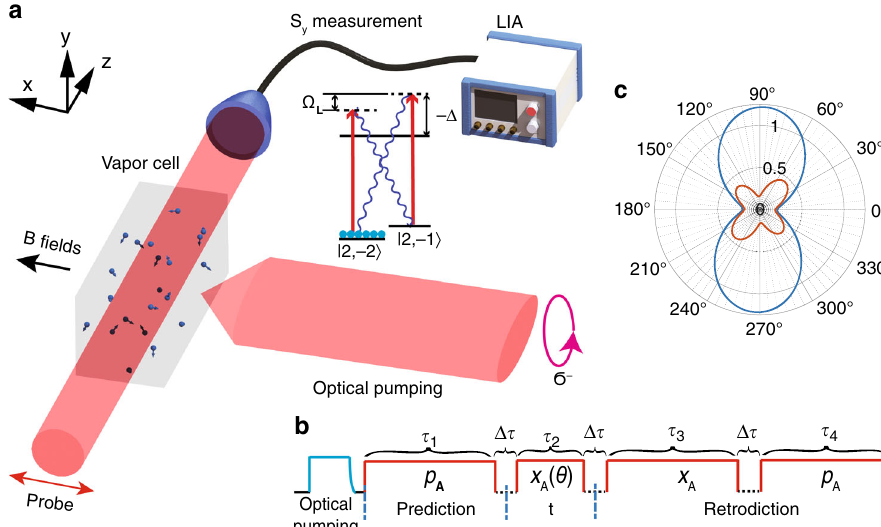
Fig. 1 Schematics for retrodiction beyond the Heisenberg uncertainty relation. a Experiment schematics. A paraf fi n coated 20mm × 7mm × 7mm rectangular vapor cell at 53 °C resides inside a 4-layer magnetic shielding. A coherent spin state (CSS) is created along the quantization axis x by optical pumping, with a pump laser tuned to the Rb D1 transition 5 S 1 = 2 ; F ¼ 2 ! 5 P 1 = 2 ; F 0 ¼ 2 and a repump laser beam stabilized to the Rb D2 transition 5 S 1 = 2 ; F ¼ 1 ! 5 P 3 = 2 ; F 0 ¼ 2, sharing the same circular polarization. A magnetic fi eld of 0.71G induces a ground-state Zeeman splitting of about Ω = 2 π × 500 kHz and stabilizes the collective spin component along the x direction. A linearly polarized off-resonance D2 laser beam, propagating in the L ∘ basis is measured z direction, probes the quantum fl uctuations of the spin. The Stokes component S y that characterizes the linear polarization in the ± 45 using a balanced polarimetry scheme. A Lock-in ampli fi er (LIA) extracts the signal at the Lamor frequency. b Pulse sequence. The pump lasers prepare the atoms in the CSS. The pump lasers are turned off and the probe laser is turned on to interact with the atoms. The probe pulse sequence is divided in four parts, measuring the quadratures indicated in the fi gure. c Theoretical polar plot of the variance of the atomic oscillator quadratures conditioned on prior (blue curve) and on prior and posterior measurements (red curve). The plot assumes ideal experiments without decoherence and decay, probing strengths κ 2 ¼ 1 : 7, κ 2 ¼ 3 : 3 and κ 2 ¼ 2 : 2 and a duty factor of 14%, for details see Supplementary Note 4. The radial distance of 0.5 in the polar plot represents the 1 3 4 SQL, and the retrodicted variances of the horizontal and vertical ^ p A and ^ x A quadratures are both reduced in violation of the HUR.